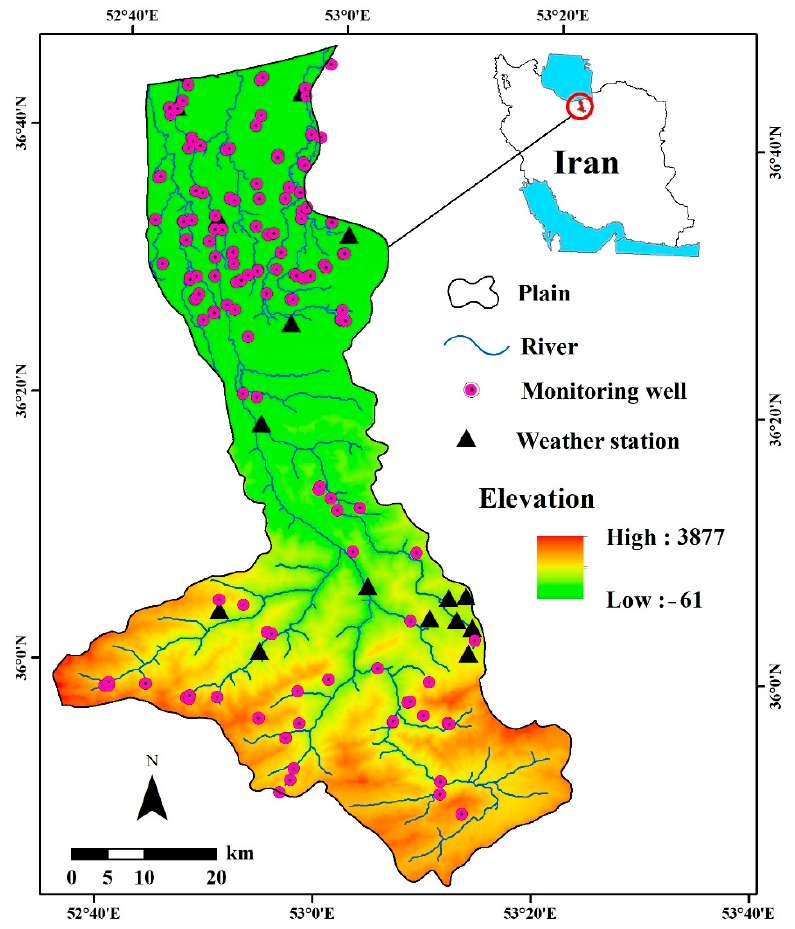
Figure 1. Location of the Ghaemshahr-Joibar plain in Mazandaran province, Iran.